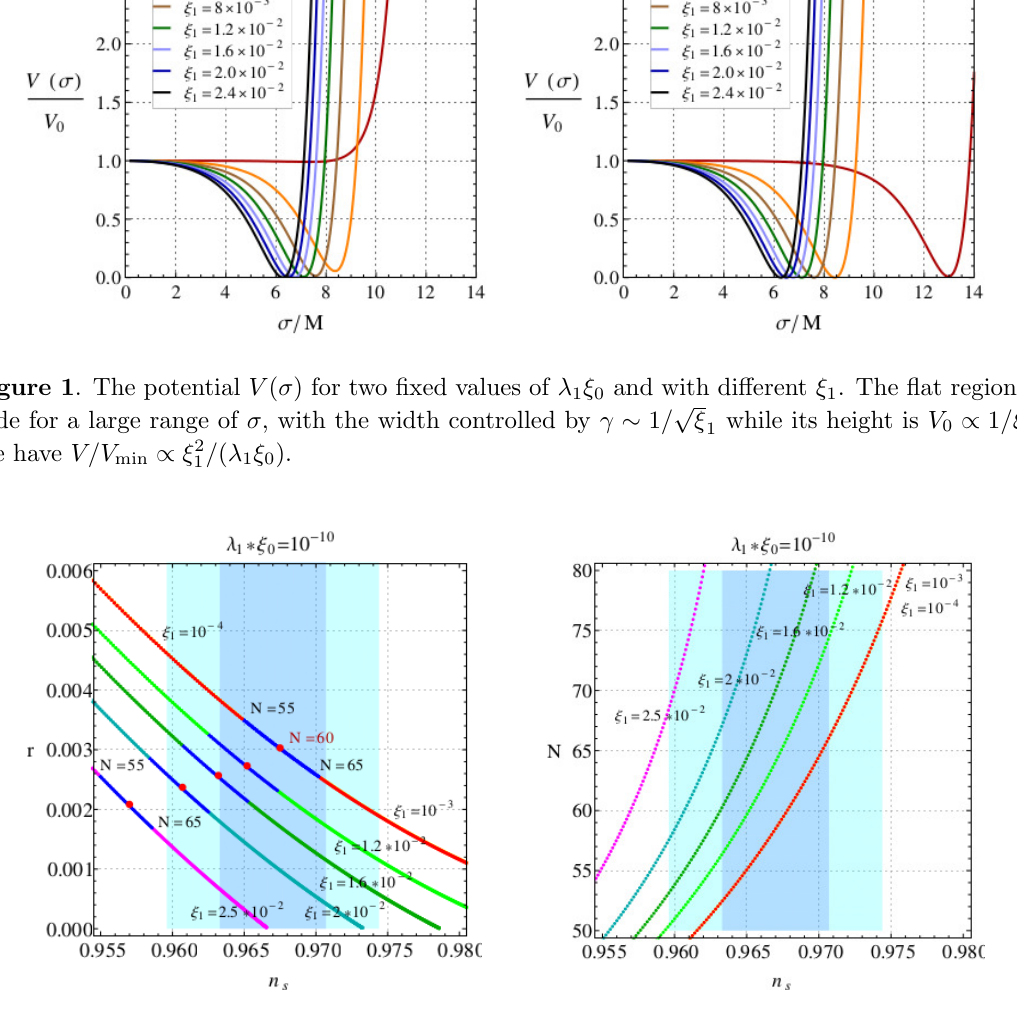
Figure 2 . The spectral index n s versus r (left plot) and n s versus N (right plot), for models with (cid:21) 1 (cid:24) 0 = 10 (cid:0) 10 and with di(cid:11)erent (cid:24) 1 . N varies along each curve; in the left plot, on each curve of (cid:12)xed (cid:24) 1 , the dark-blue curve has N = 55 and N = 65 at its left and right ends, respectively. The red dots correspond to N = 60. The curves for (cid:24) 1 = 10 (cid:0) 3 and (cid:24) 1 = 10 (cid:0) 4 are nearly identical (saturated bound as (cid:24) 1 ! 0) in both plots. Blue (light blue) regions correspond to n s given by n s = 0 : 9670 (cid:6) 0 : 0037 at 68 % CL (95 % CL) respectively [58]. The constraint r < 0 : 07 is easily satis(cid:12)ed. The value of r is very small, below that of Starobinsky case: for N = 60 we have r (cid:20) 0 : 00303 (from top curve, saturated bound as (cid:24) 1 ! 0) and r> 0 : 00257 from the lower bound on n s (68% CL) with (cid:24) 1 = 1 : 6 (cid:2) 10 (cid:0) 2 .